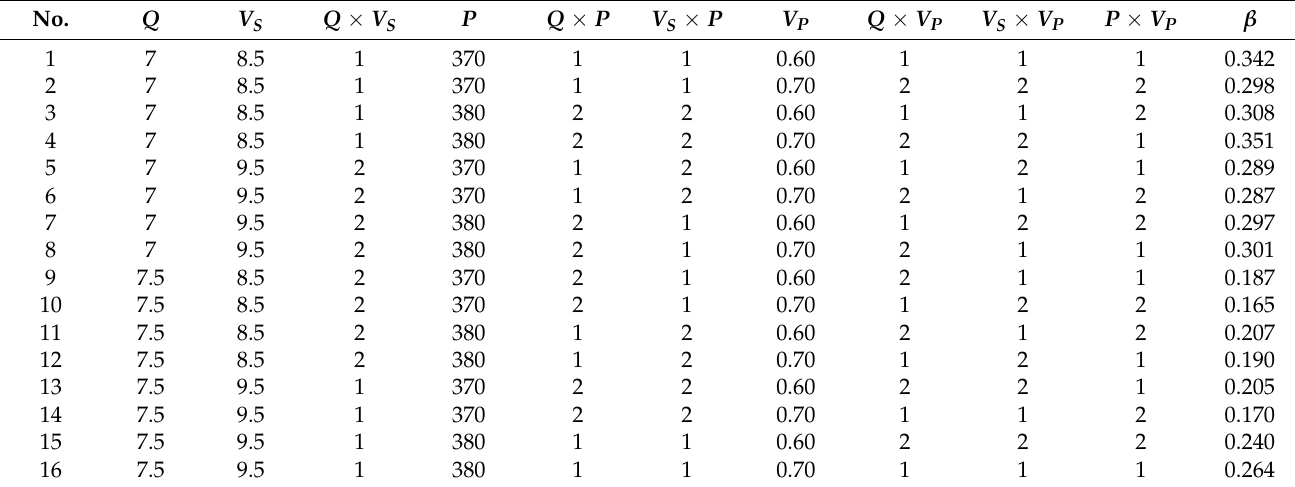
Table 3. Design and results of interaction